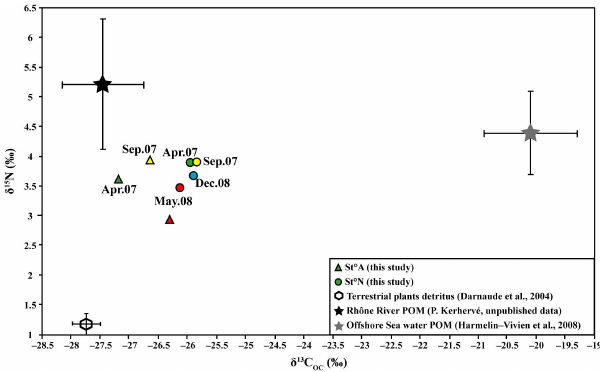
Fig. 9. Stable isotopic composition of the organic matter ( δ 13 C OC vs. δ 15 N) from the first half-centimetre of sediment at both Stations A and N (except for December 2008 at Station A; no available δ 15 N value). The composition of three possible OC sources (Terrestrial plant detritus, Rh ˆ one River POM, and offshore seawater POM) are also plotted to illustrate the relative influence of each source. The Rhˆone River POM is the mean signature of the river between 2006 and 2008 (monthly sampling; Kerherv´e et al., 2012).